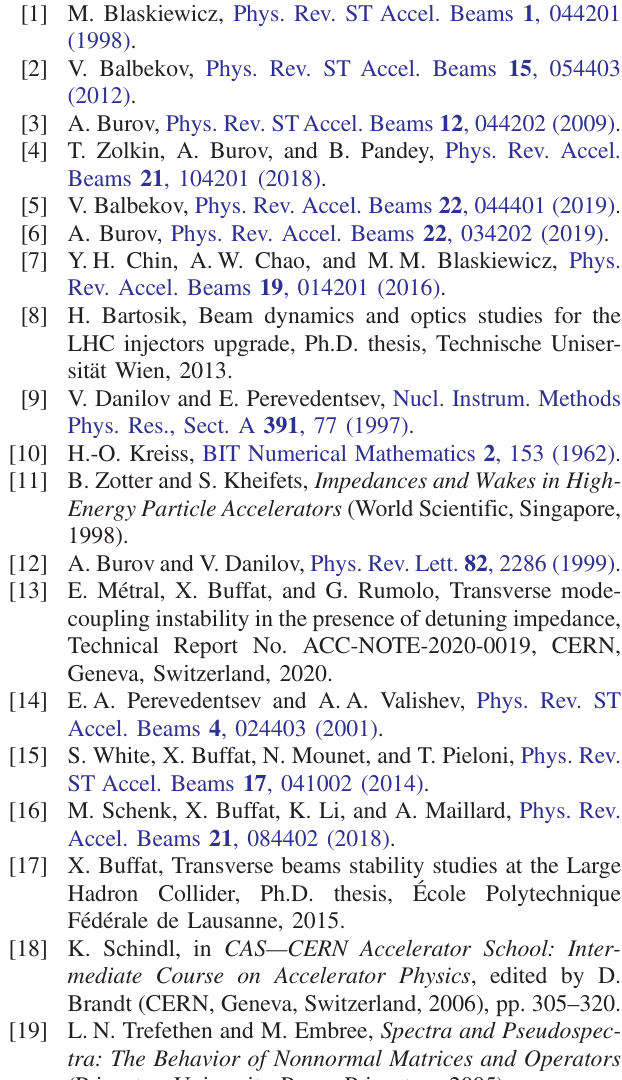
displacement of the head of the bunch, under multiplications by the one turn matrix corresponding to a normalized intensity of 20 and a space charge tune shift of 20. The airbag model was considered with 100 slices. The transverse position is normalized to the maximum offset at the head of the bunch in the initial